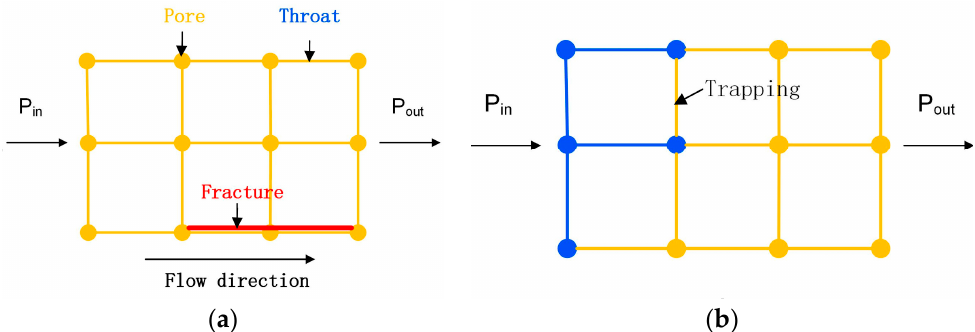
Figure 1. Basic units of PFNM. ( a ) Structure of PFNM; ( b ) Trapping mechanism (The process of two-phase displacement, where blue represents the pores and the throats are filled with wetting phase, and orange represents the pores and the throats are filled with non-wetting phase).